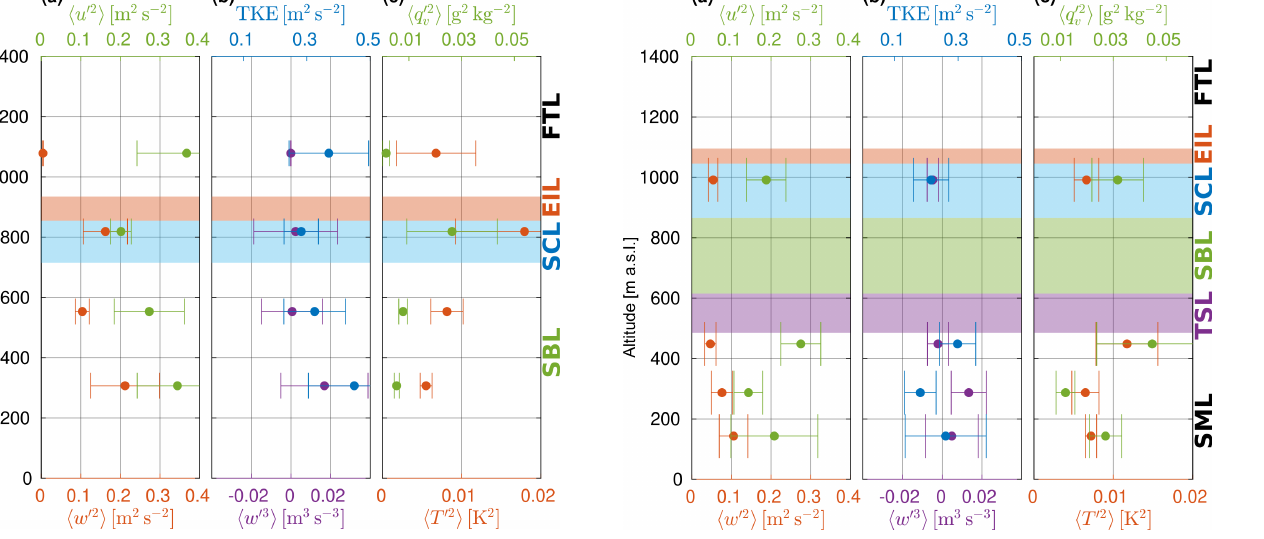
Figure 10. As in Fig. 9 but for the decoupled STBL (fight no.